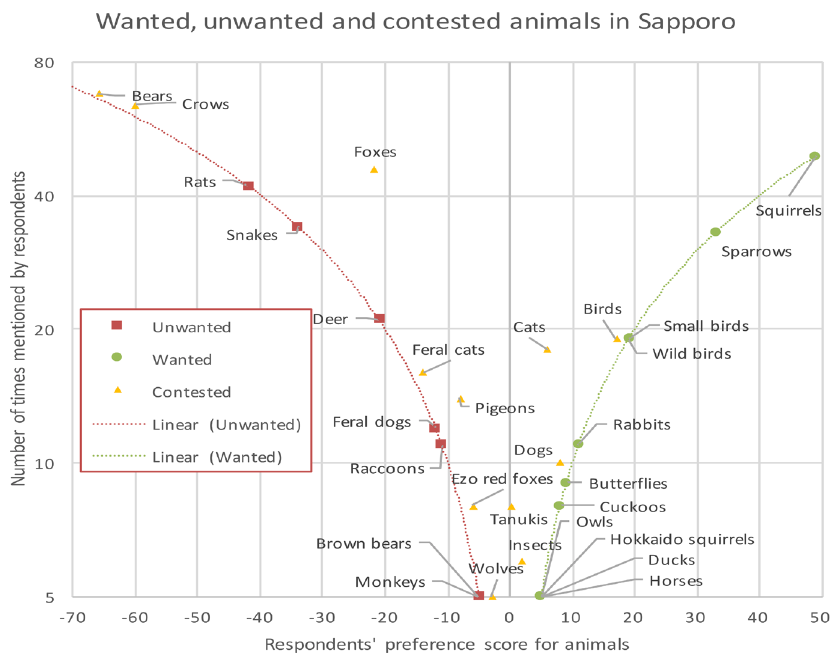
Fig. 2. Sapporo respondents’ preferences for animals in their